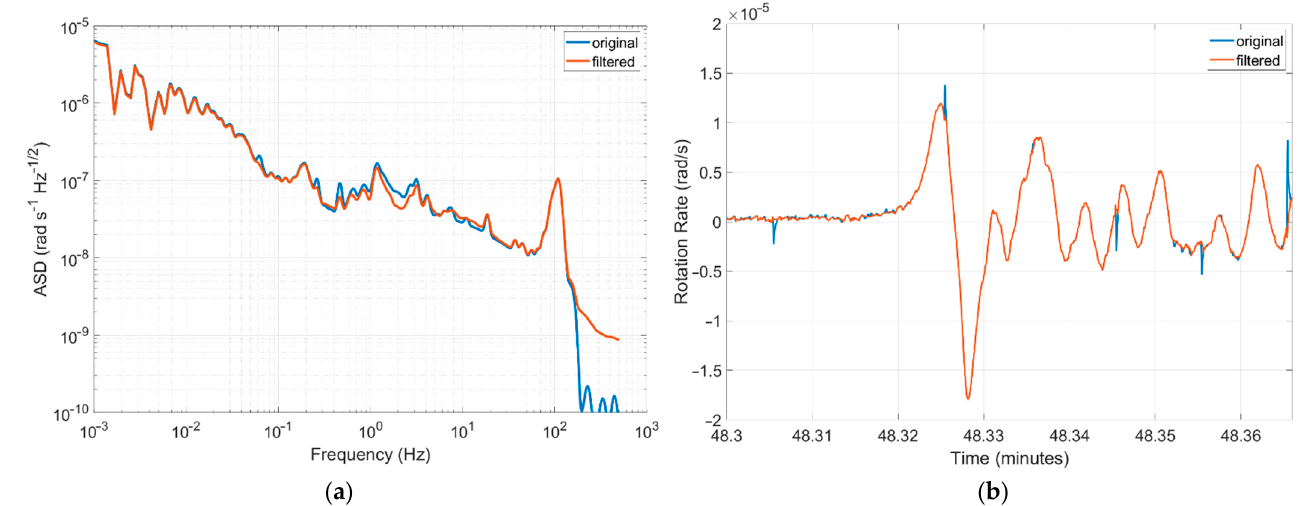
Figure 10. Accuracy of the applied method for the elimination of artefacts: ( a ) comparison of the ASD characteristics of the FOS5-04 with and without signal filtering, and ( b) seismogram with rotational events and their disturbance by artefact filtering.